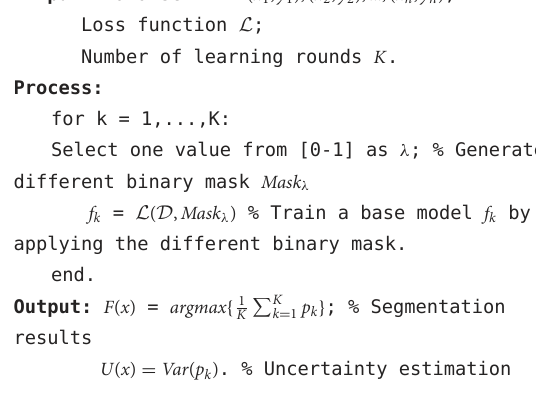
Algorithm 1. Ensembles learning via Supervision